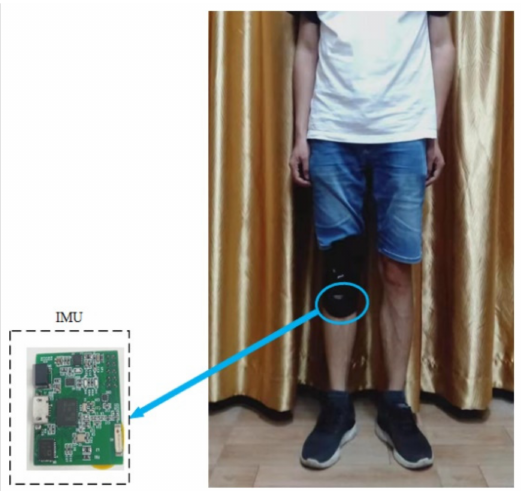
Figure 5. Fixed position of IMU